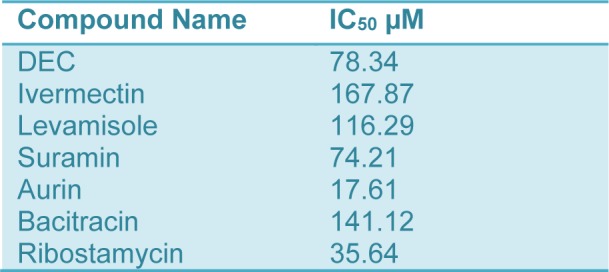
IC50 values of some antifilarials and specific compounds against BmPDI